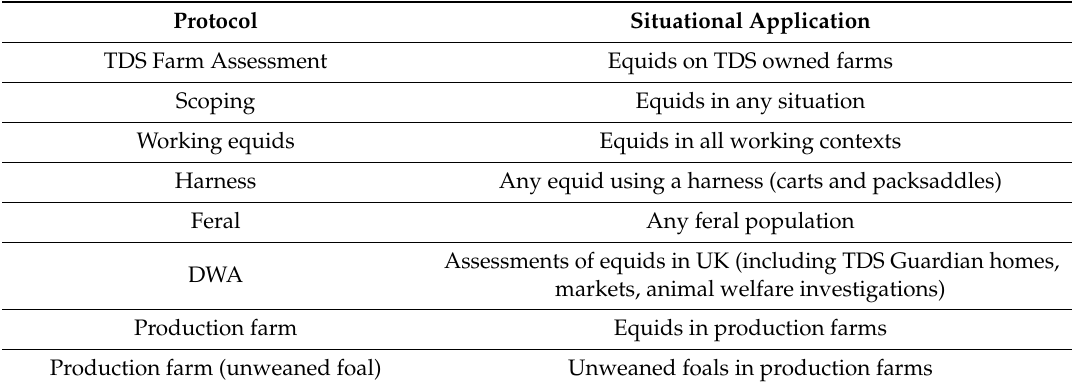
Table 2. List of EARS tool protocols developed by the Donkey Sanctuary as of December